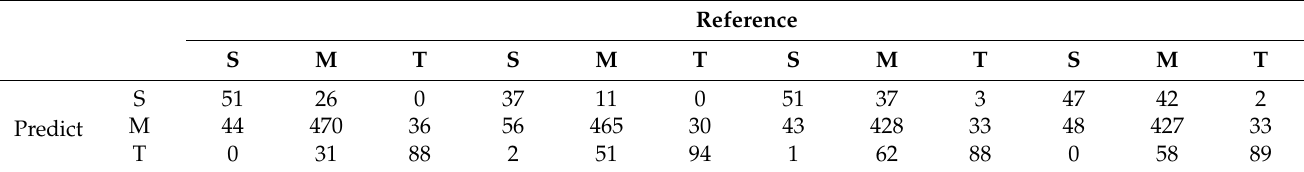
Table 3. Confusion matrix of the selected four deep learning models for the classification of off-target dicamba